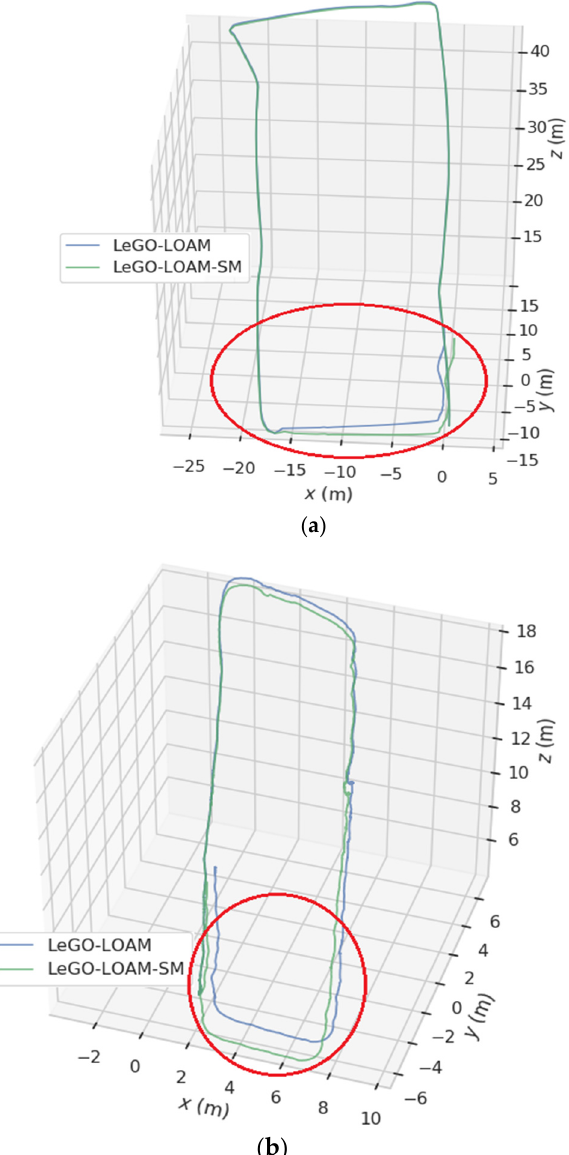
Figure 12. The motion estimation trajectories of LeGO-LOAM and LeGO-LOAM-SM: ( a ) for Scene 1; and ( b ) for Scene 2.